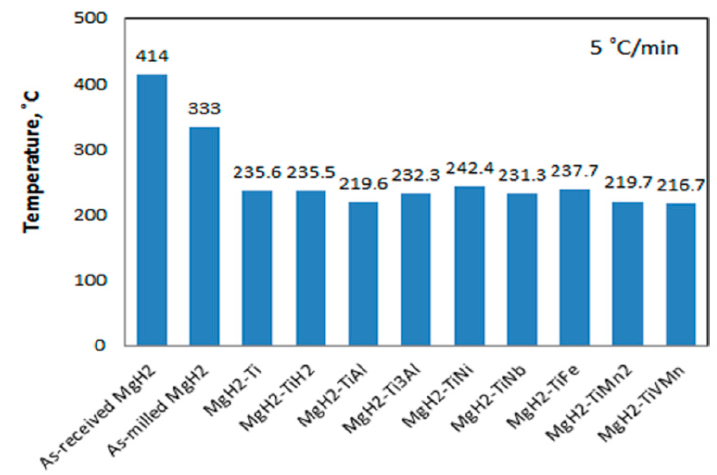
Figure 4. Dehydrogenation temperature of different Ti-based catalysts doped systems, determined by thermal gravimetric analyzer (TGA) profiles at fractional conversion α = 0.4 [179].